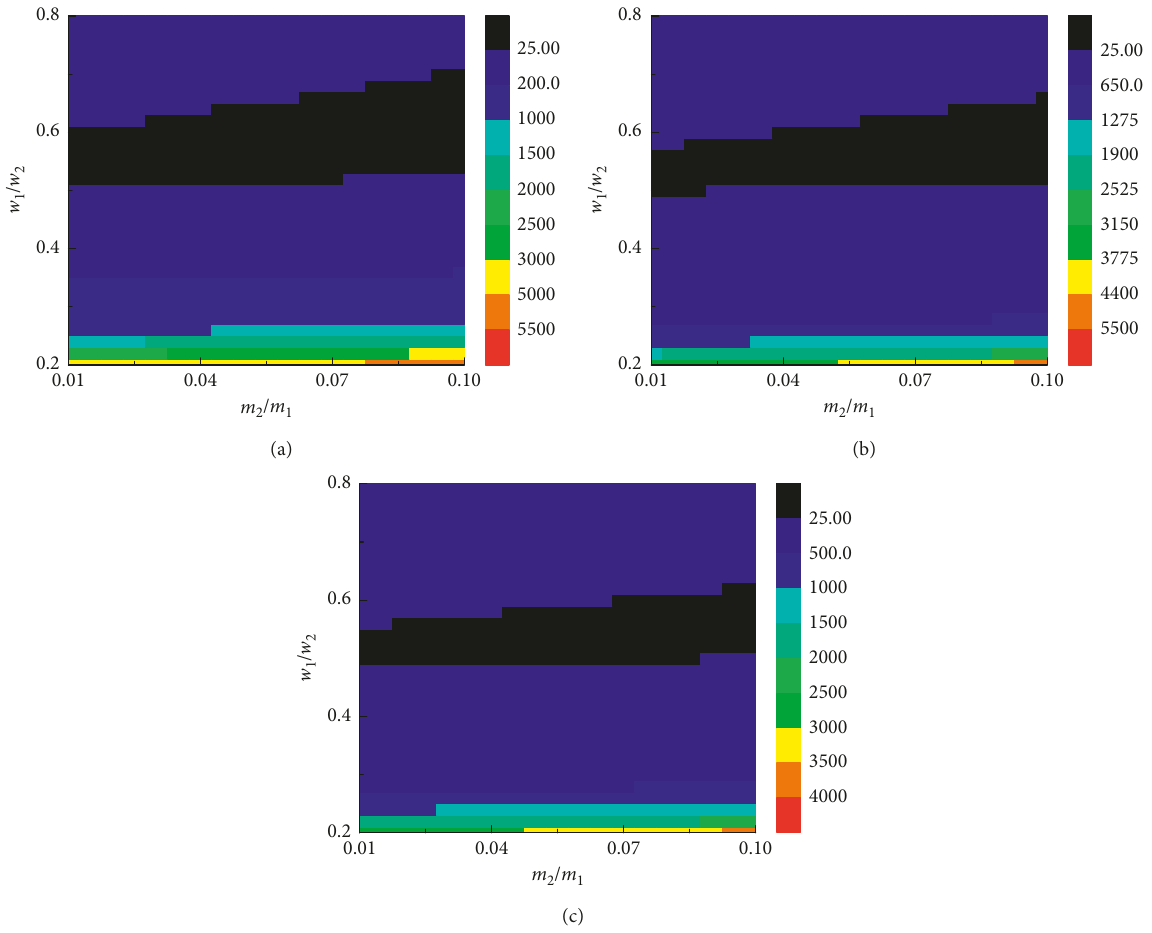
Figure 5: Optimization results of primary-secondary coupled interactive damping system under different weights. (a) Weight coefficients are 0.6+0.4. (b) Weight coefficients are 0.5+0.5. (c) Weight coefficients are 0.4+0.6.